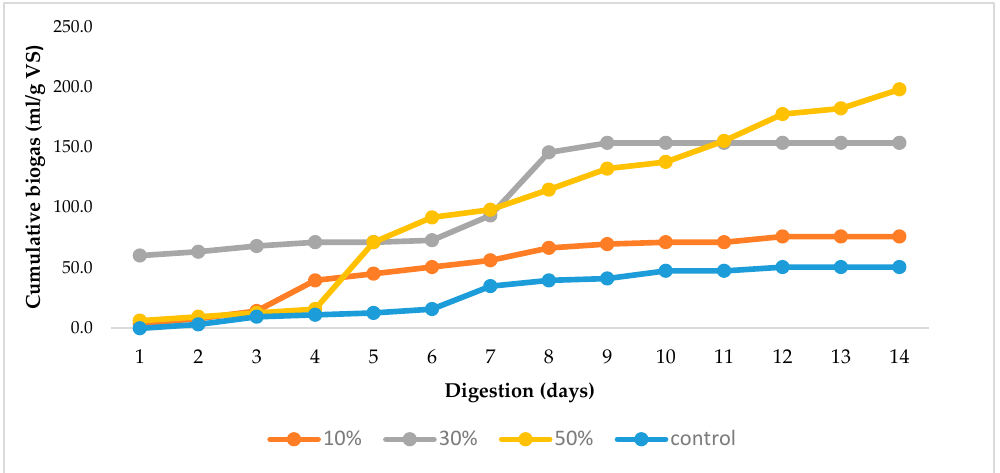
Figure 9. The cumulative biogas production as mL of cumulated biogas volume/g of VS loaded.